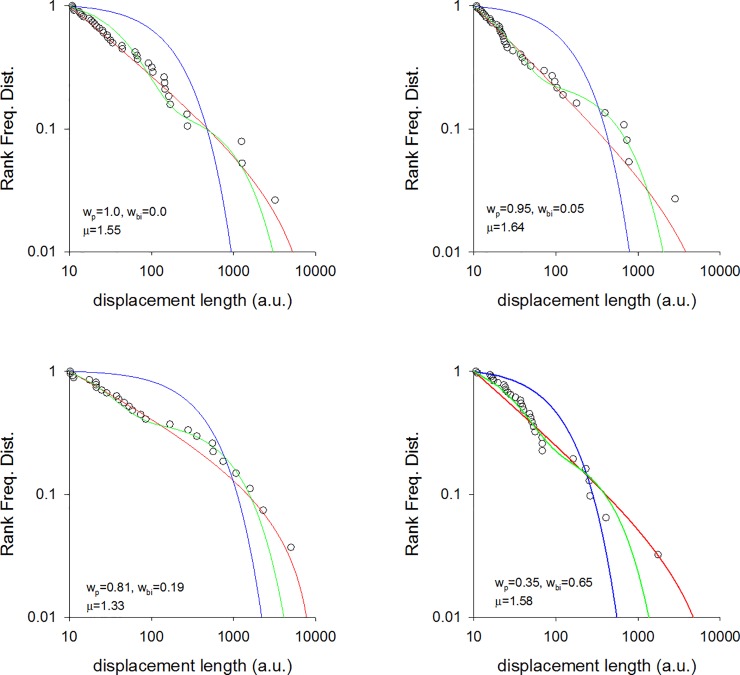
Fittings to the step length distribution for 4 simulated individuals.Rank frequency plots of the step lengths are shown (o) together with fits to power-law (red-lines), exponential (blue lines) and bi-exponentials (green lines). The Akaike weights, wp and wbi, for the power-law and bi-exponential fits are shown together with the maximum likelihood estimates for the power-laws (Lévy) exponent, μ. Individuals perform random walks when making excursions. There is a single, straight trail. The walker moves with constant speed parallel to the trail and moves randomly in the orthogonal direction. Step-lengths in these random walks are exponentially distributed with mean length 1 a.u. An excursion ends when the walker first returns to the trail.